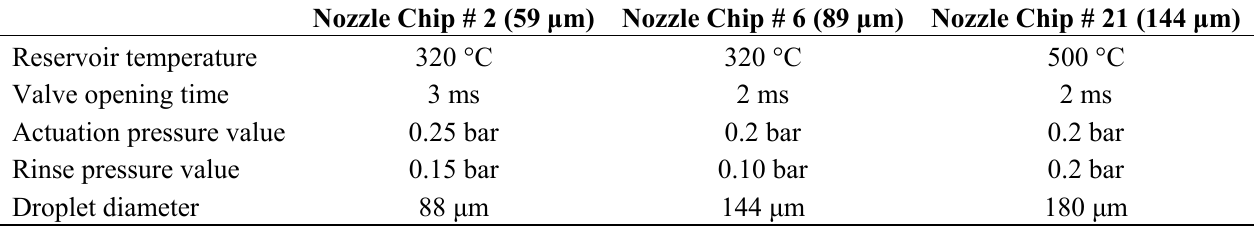
Table 3. Printing parameters for Drop-on-Demand experiments.